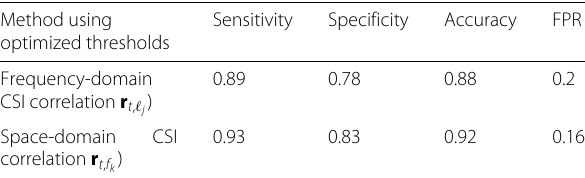
Table 3 Performance evaluation of target detection with measurements related to a single and double target moving along the main LOS path (i.e., only the receiver RX2); both space- and frequency-domain correlation methods with a single threshold are employed Method using single Sensitivity Specificity threshold Frequency-domain ) CSI correlation r t , (cid:2) j